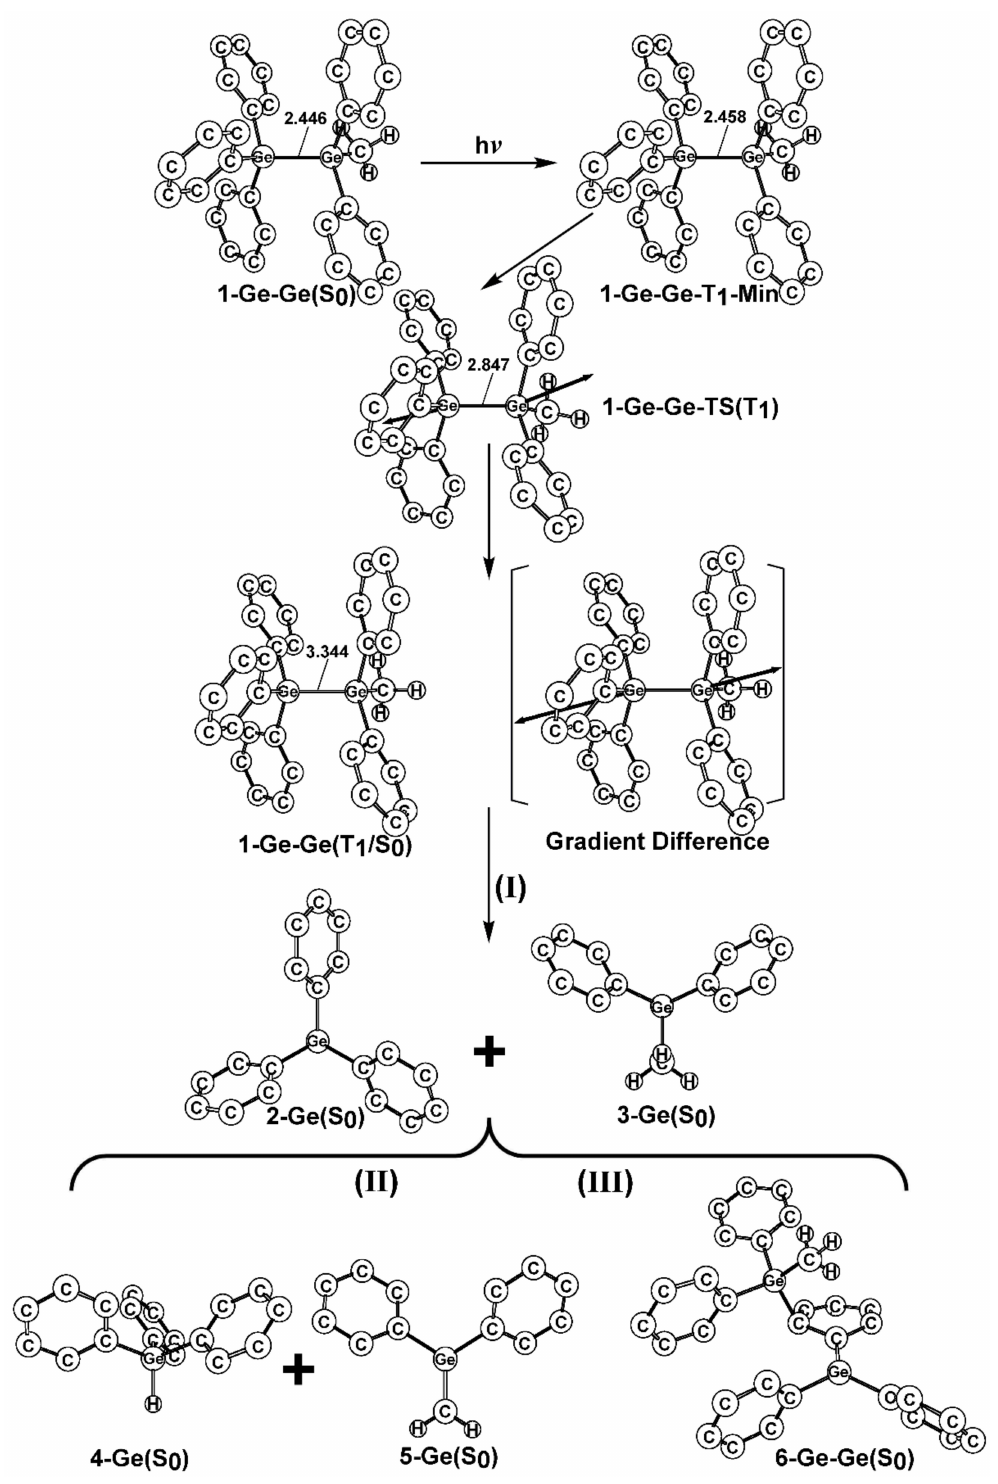
Figure 6. The optimized structures for the photochemical isomerization model of Ph 3 Ge–GePh 2 Me at the M06-2X/6-311G(d) level of